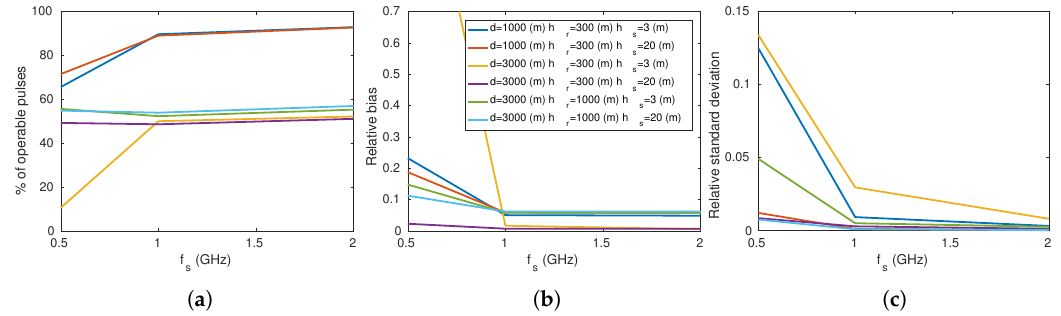
Figure 9. Percentage of operable pulses ( a ), relative bias ( b ) and relative standard deviation ( c ) as a function of the sampling frequency f s , the radar height h r , the scatterer height h S and the projected radar distance d . Table 4. Results for different